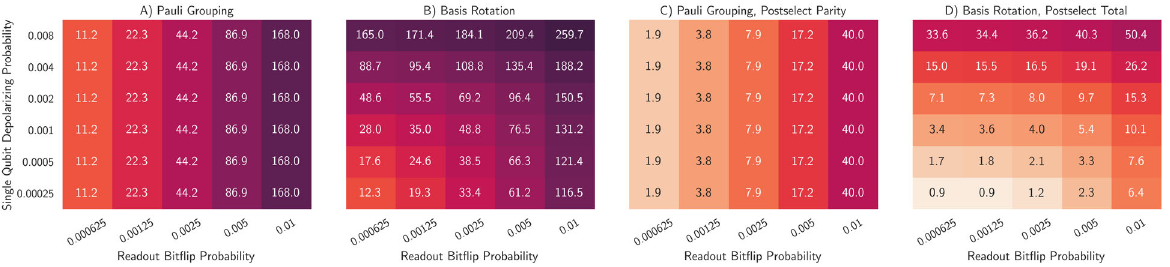
Fig. 4 The error in the ground state energy of a hydrogen chain using various measurement strategies and a noisy state preparation step. We report the error in millihartrees for measurements of the ground state energy of a stretched chain of six hydrogen atoms under an error model composed of single-qubit dephasing noise applied after every two-qubit gate together with a symmetric bit fl ip channel during readout. We consider single-qubit depolarizing noise with probabilities ranging from 2.5 × 10 − 4 to 8 × 10 − 3 , corresponding to two-qubit gate error rates of ≈ 5 × 10 − 4 to 1.6 × 10 − 2 . For the measurement noise, we take the single-qubit bit fl ip error probabilities to be between 6.25 × 10 − 4 and 1 × 10 − 2 . From left to right: A The error incurred by a Pauli Grouping measurement strategy involving simultaneously measuring compatible Pauli words in the usual molecular orbital basis. B The error when using our Basis Rotation Grouping scheme, which performs a change of single-particle basis before measurement. C The errors using the same Pauli Word Grouping strategy together with additional measurements and postprocessing, which effectively project the measured state onto a manifold with the correct parities of the total particle number and S z operators. D Those found when using our basis rotation strategy and postselecting on outcomes where the correct particle number and S z were observed. In all panels, for the purpose of approximating a realistic ansatz circuit, three random Givens rotation networks that compose to the identity were simulated acting on the ground state prior to